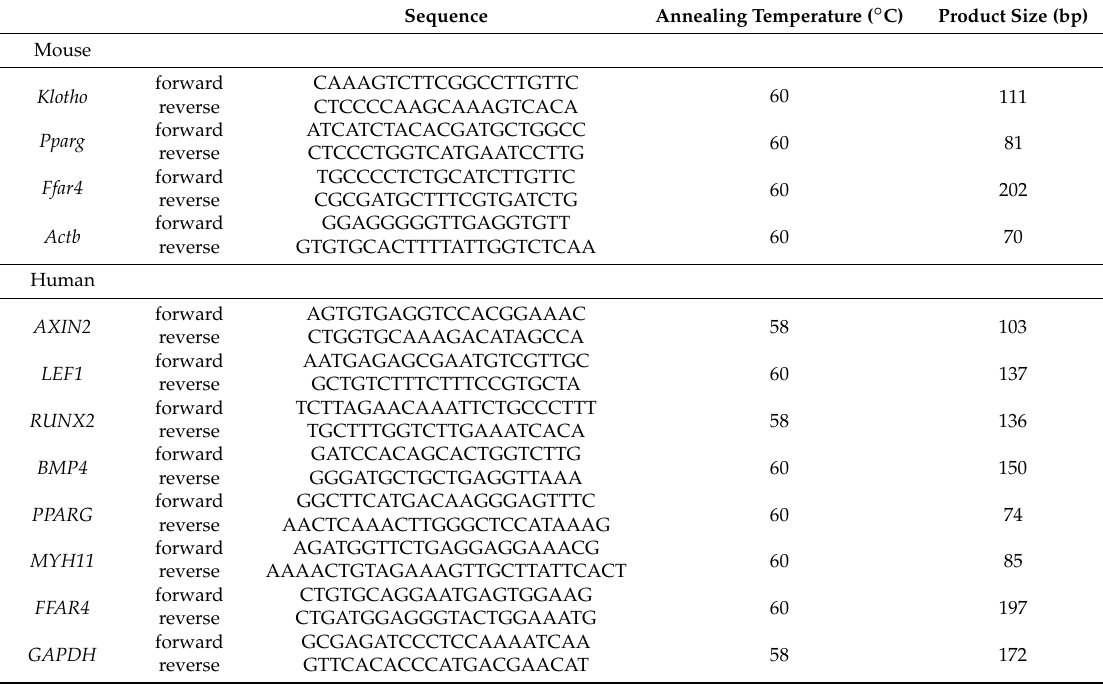
Table 1. PCR primer